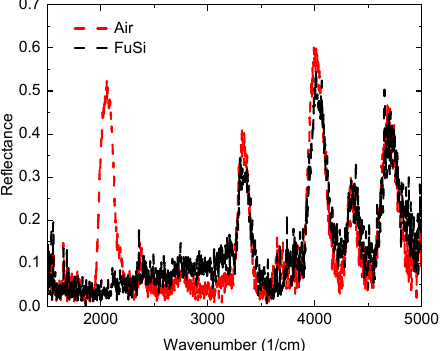
Figure 3. Fourier-transform infrared reflection measurements of the fabricated photonic crystal measured both in air (black dashed) and through a Fused Silica substrate (red dashed). At this stage, there is no compression on the photonic crystal.